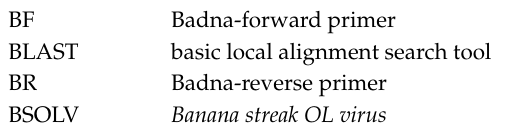
Figure S1: Denaturing gradient gel electrophoresis (DGGE) analysis of partial RT-RNaseH badnavirus sequences from eleven samples consisting of cross-breeding lines of D. alata , Figure S2: Protein alignment from deduced amino acid sequences of partial RT-RNaseH nucleotide sequences of 114 yam badnavirus sequences determined in this study together with other members of the family Caulimoviridae , Table S1: Nucleotide percent similarity